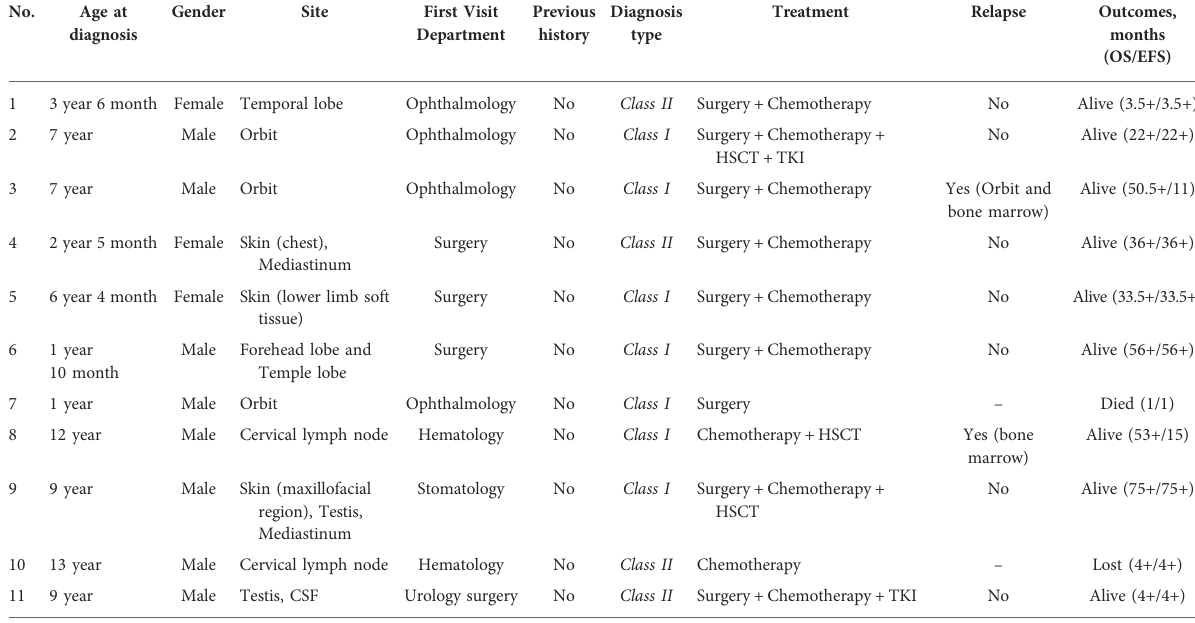
TABLE 1 Clinical characteristics and outcomes of the patients with